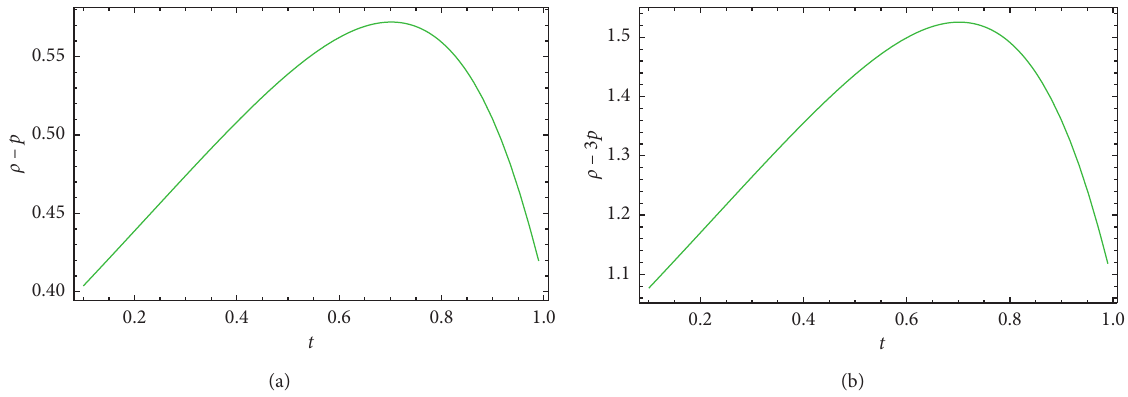
Figure 9: Evolution of DEC and TEC for ω − 0 . 0005 ; s �